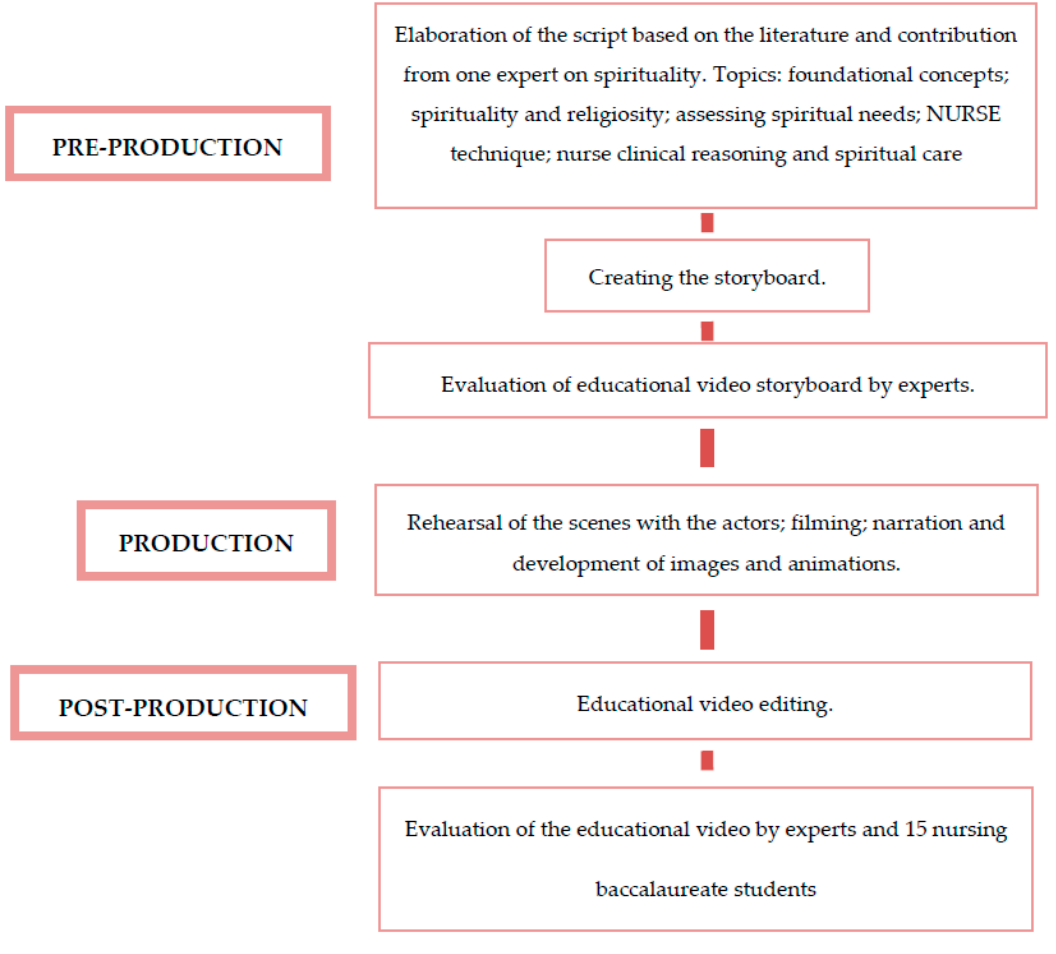
Figure 1. Phases of construction of the educational video, adapted from reference (Fleming et al. 2009).